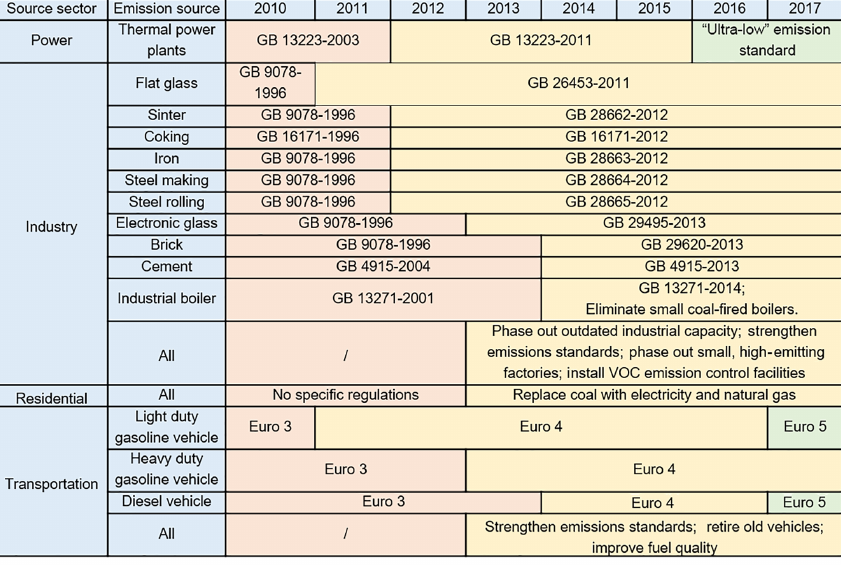
Figure 1. China’s clean air policies implemented during